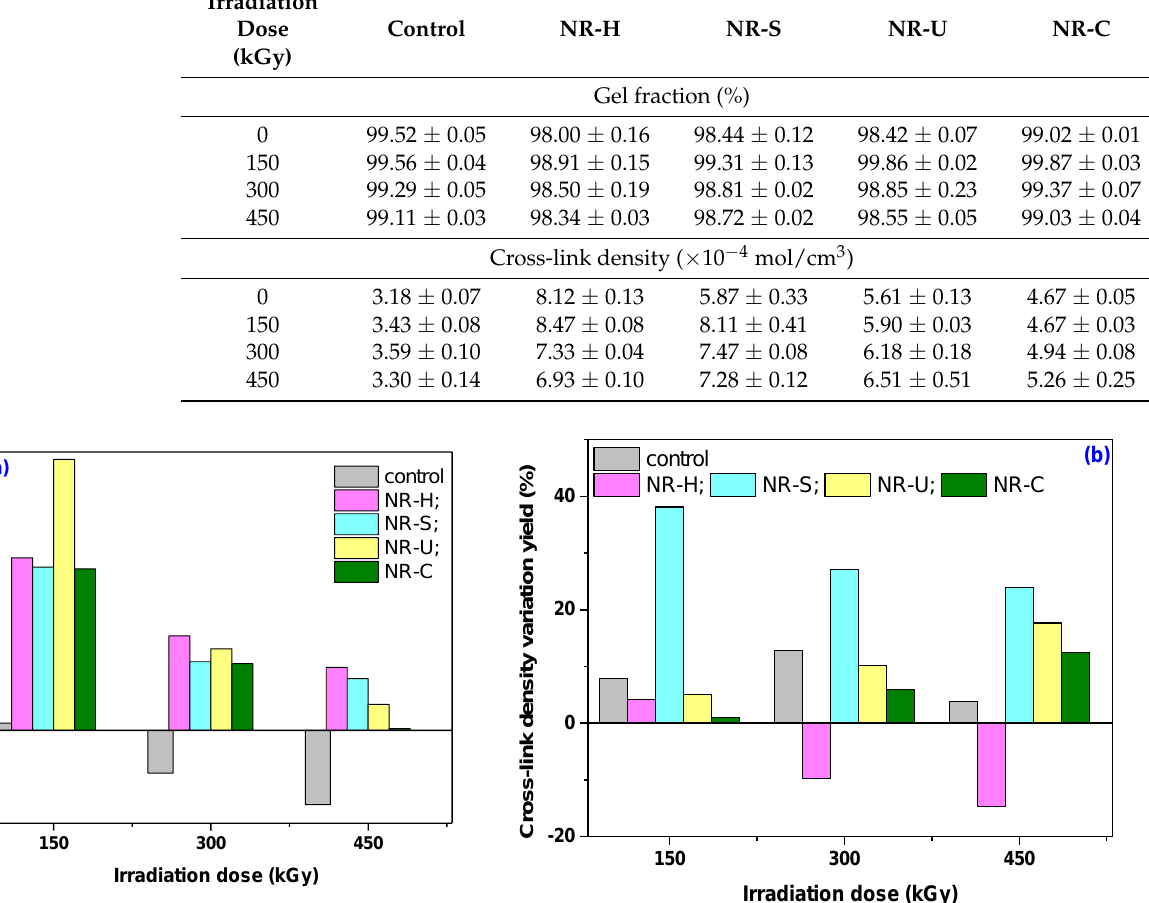
Figure 2. The gel fraction ( a ) and cross-link density ( b ) variation yield of the irradiated versus non-irradiated samples. Table 4. The gel fraction and cross-link density variation as a function of irradiation dose and filler type